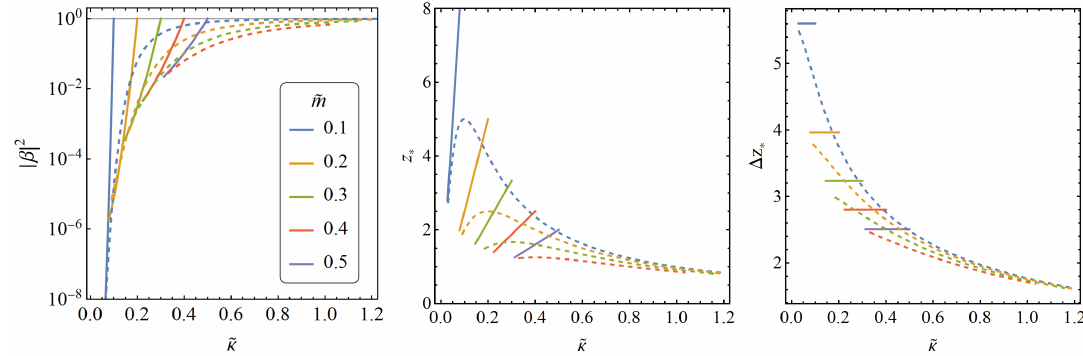
Figure 22 . The production histories in radiation-dominated era. Left panel: production amount as a function of the dimensionless chemical potential for different particle masses. Middle panel: the z -domain production time dependence on chemical potential and mass. Right panel: the z - domain production width. In all three plots, solid lines represent spin-1 bosons while dashed lines represent spin-1/2 fermions. Particles with different masses are distinguished by the colors of the lines according to the legend in the left panel. The parameter range is chosen according to figure 21. Due to the imposed constraint, the purple dashed line for fermions with ˜ m = 0 . 5 is absent in all three plots, since it would correspond to artificial initial conditions, as discussed in the main text